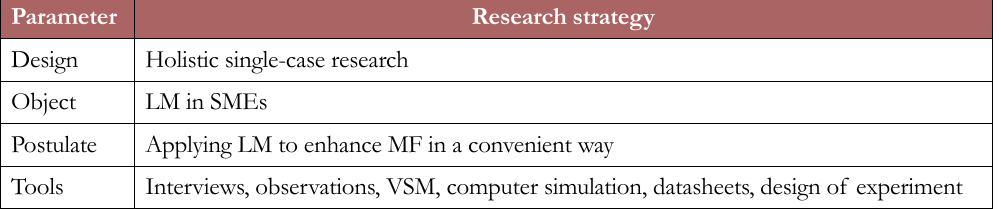
Table 1. Research